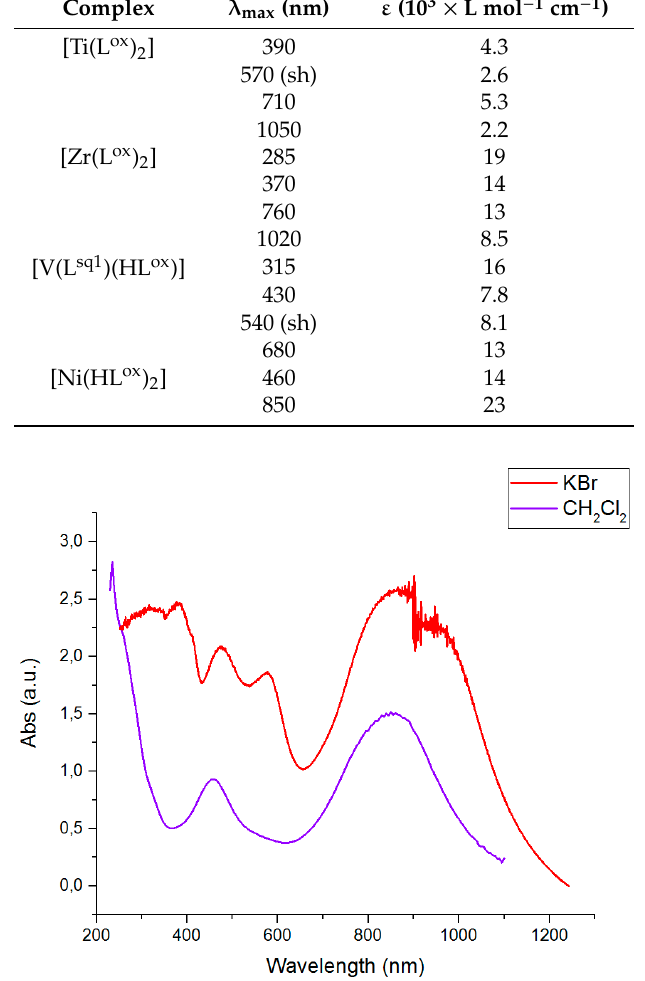
Table 4. The UV-vis-NIR absorption peaks in CH 2 Cl 2 solution and their molar absorption coefficients.